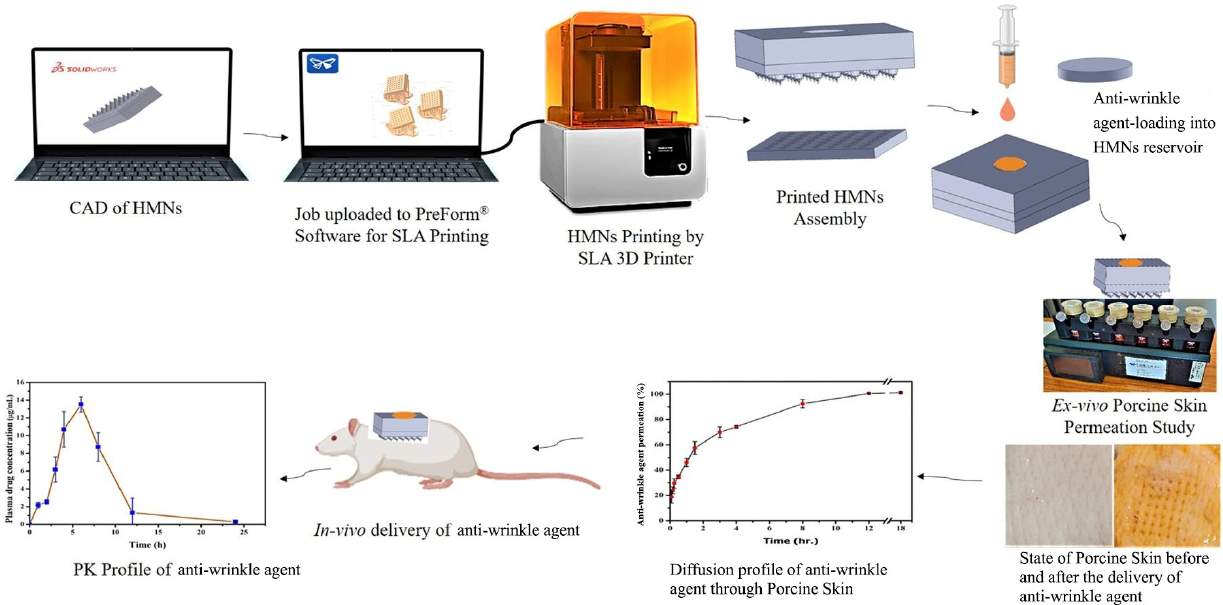
Figure 4. A schematic representation of the manufacture of 3D printed HMNs for the administration of anti-wrinkle agents [Adapted with permission from Ref. [122]].